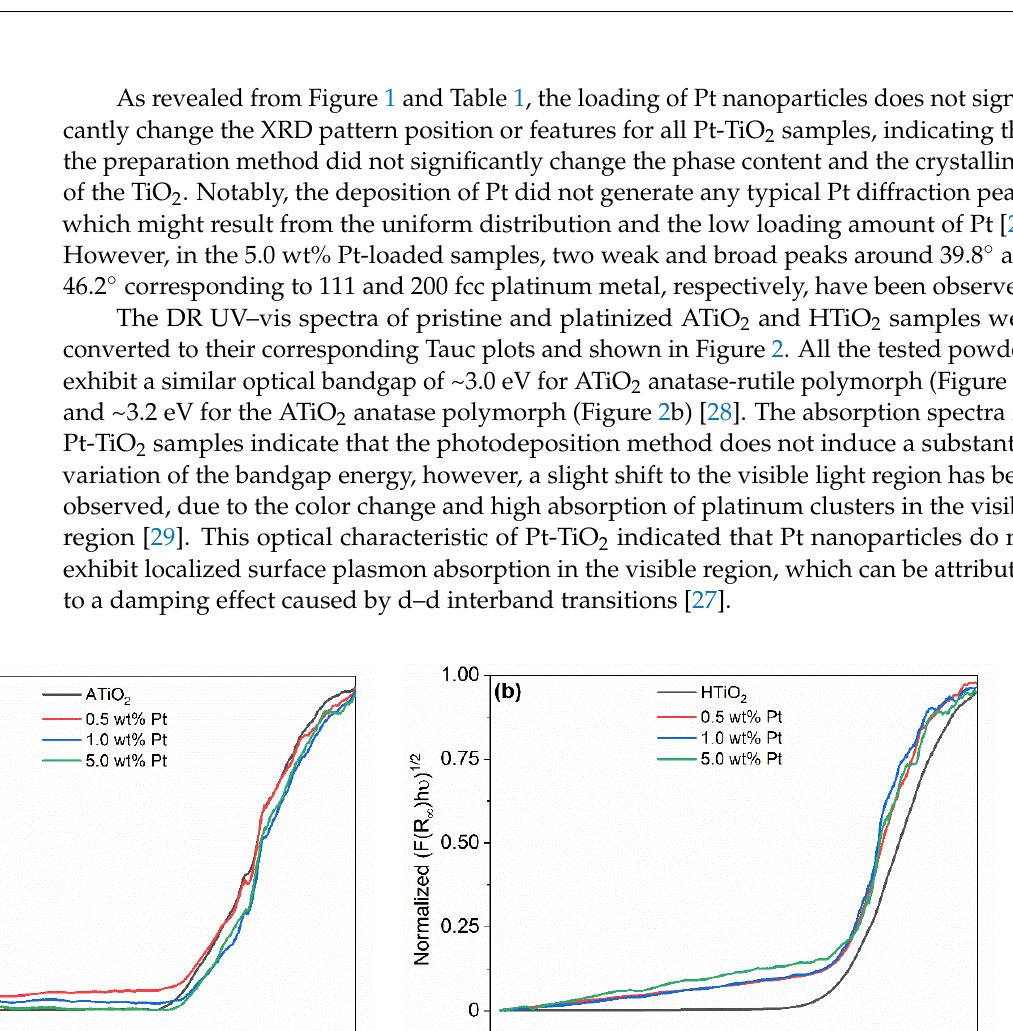
Figure 1. XRD patterns of pristine and different percentage of Pt loaded on ( a ) ATiO 2 and ( b ) HTiO 2 surfaces. A and R stand for anatase and rutile phases, respectively. The red lines in the bottom represent the Pt reference.